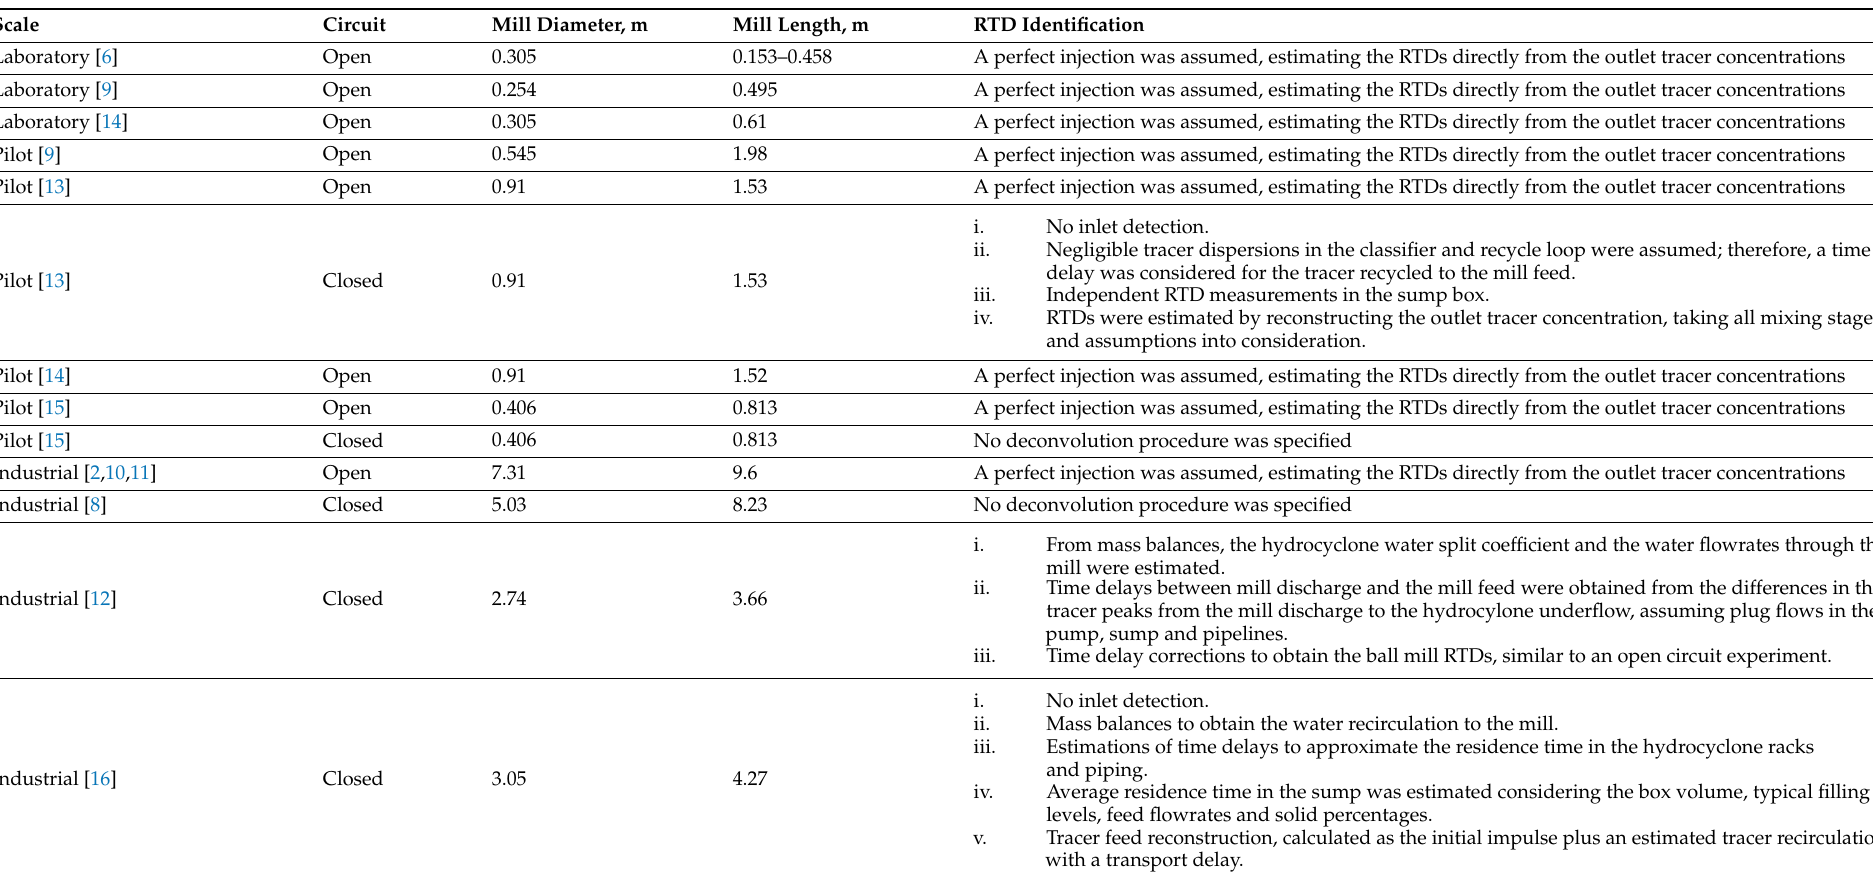
Table 1. Summary of the most relevant RTD studies on ball